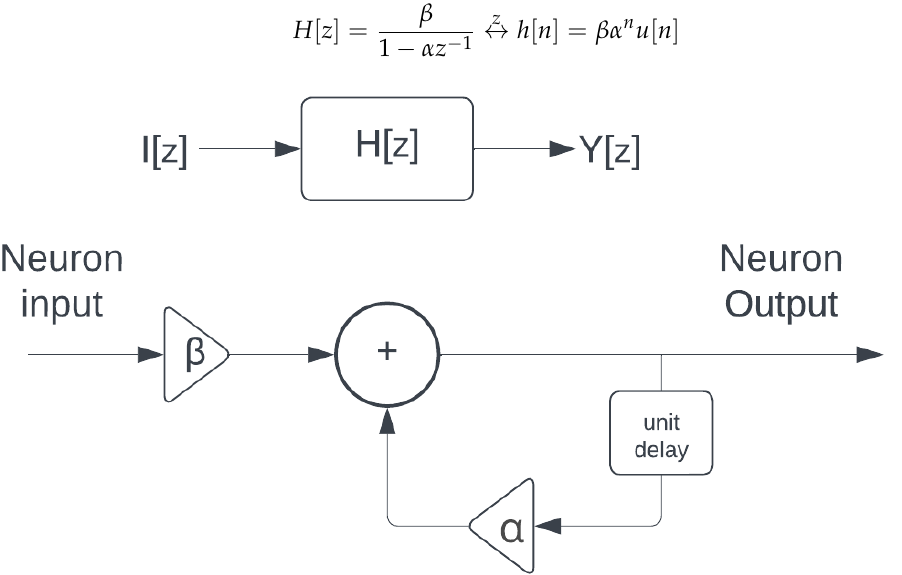
Figure 2. The block diagram of the LIF neuron system. I [ z ] and Y [ z ] are the input and output of the system, respectively.